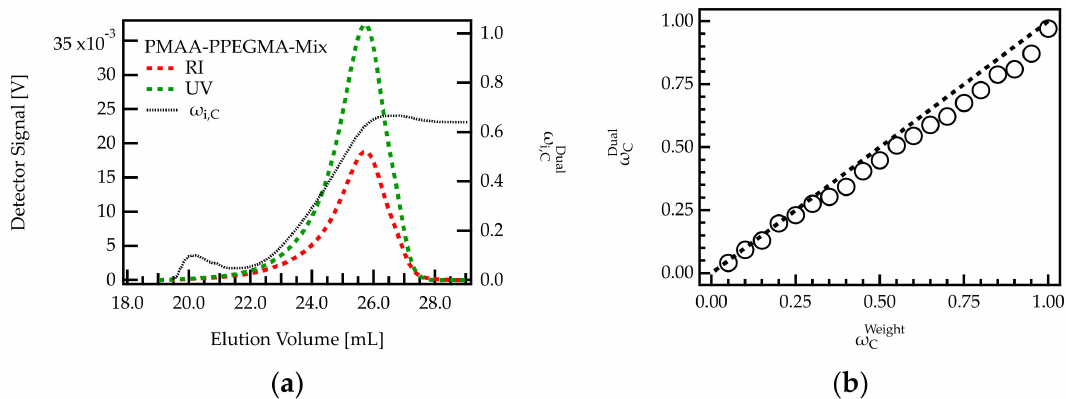
= 0.7. The C = 0.7 with ω Dual = 0.7 for 20 homopolymer C C